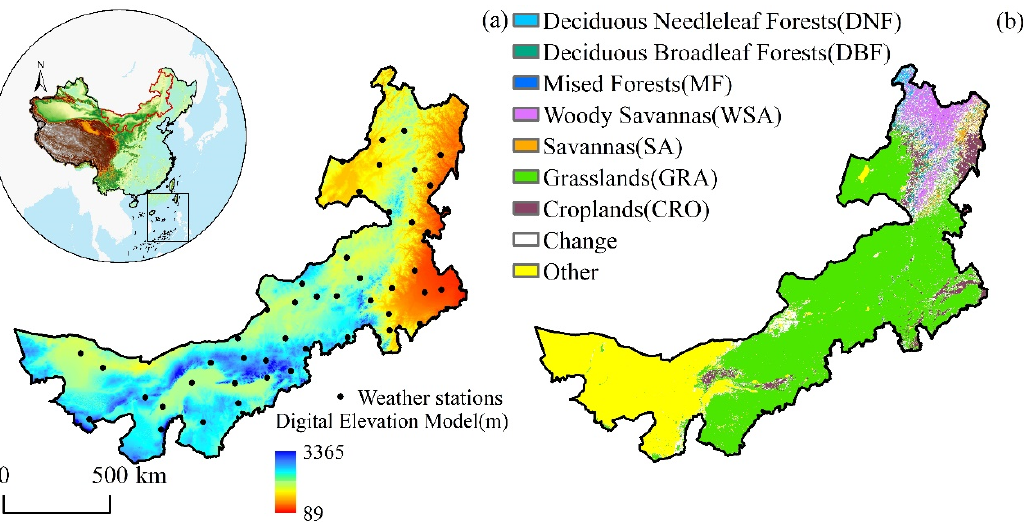
Figure 1. The geographical distribution of the study area. ( a ) Digital elevation model, ( b ) vegetation types.